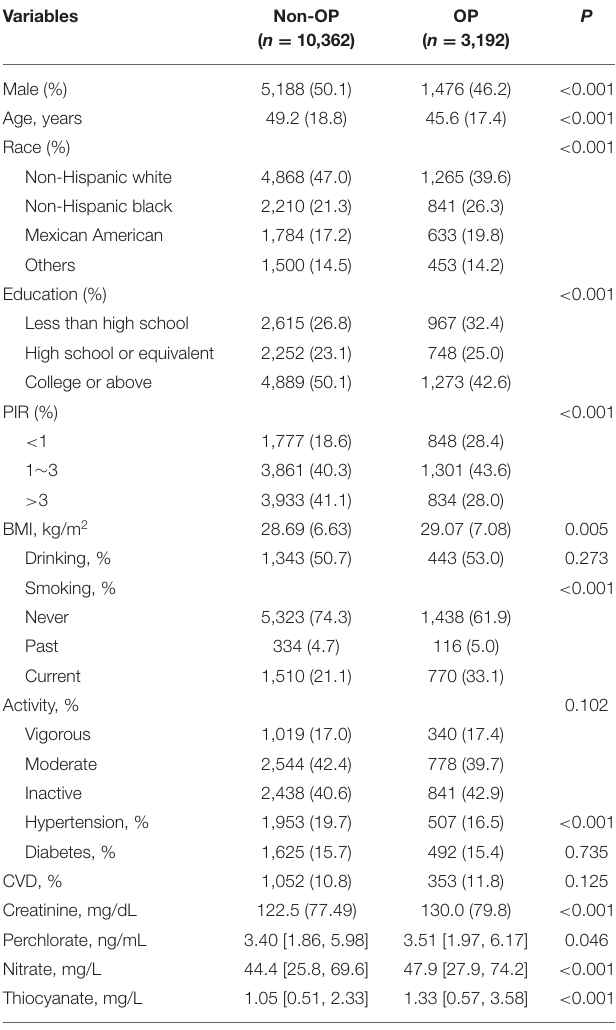
FIGURE 1 | The flow chart of participant